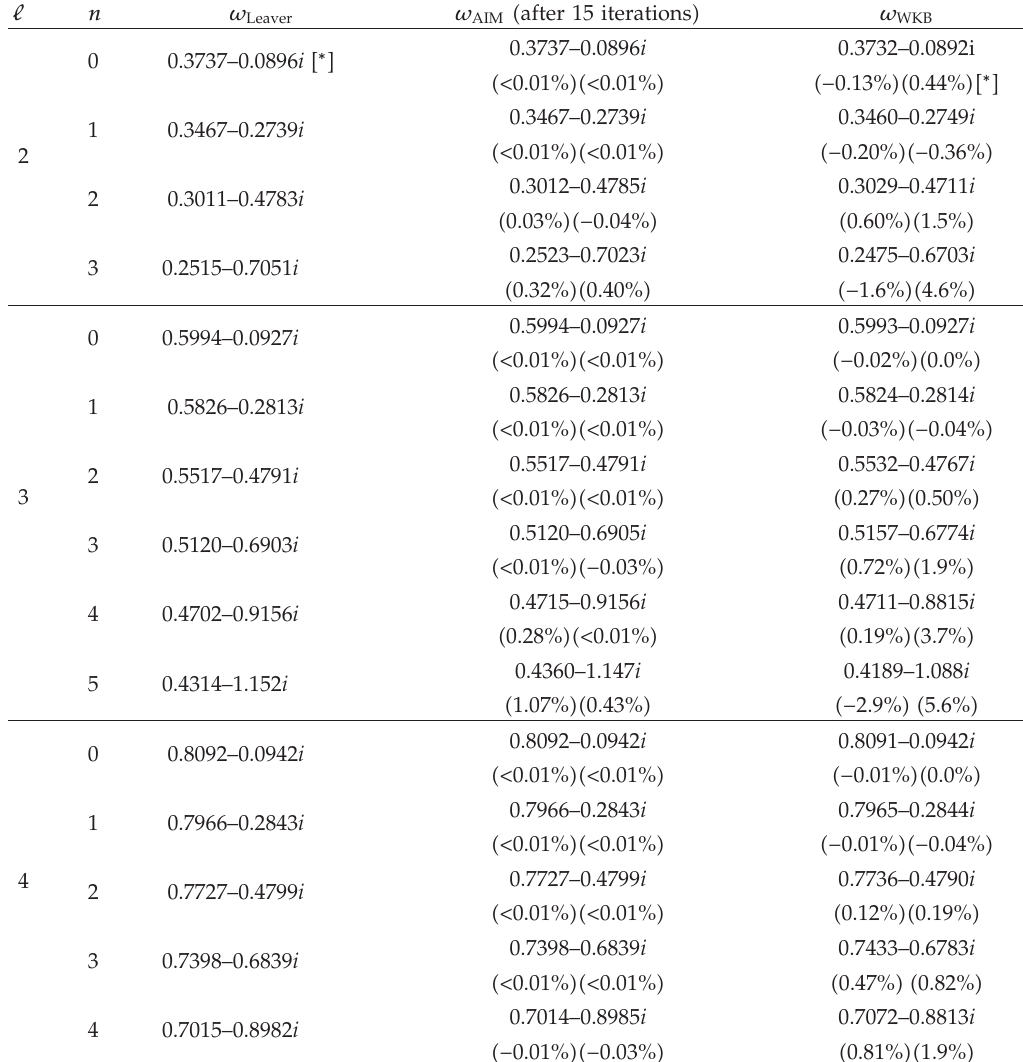
Table 1: QNMs to 4 decimal places for gravitational perturbations (cid:2) s (cid:8) 2 (cid:3) where the fifth column is taken from (cid:5) 28 (cid:6) . Note that the imaginary part of the n (cid:8) 0 and (cid:12) (cid:8) 2 result in (cid:5) 28 (cid:6) has been corrected to agree with (cid:5) 6 (cid:6) . (cid:5) ∗ (cid:6) Note also that if the number of iterations in the AIM is increased, to say 50, then we find agreement with (cid:5) 6 (cid:6) accurate to 6 significant